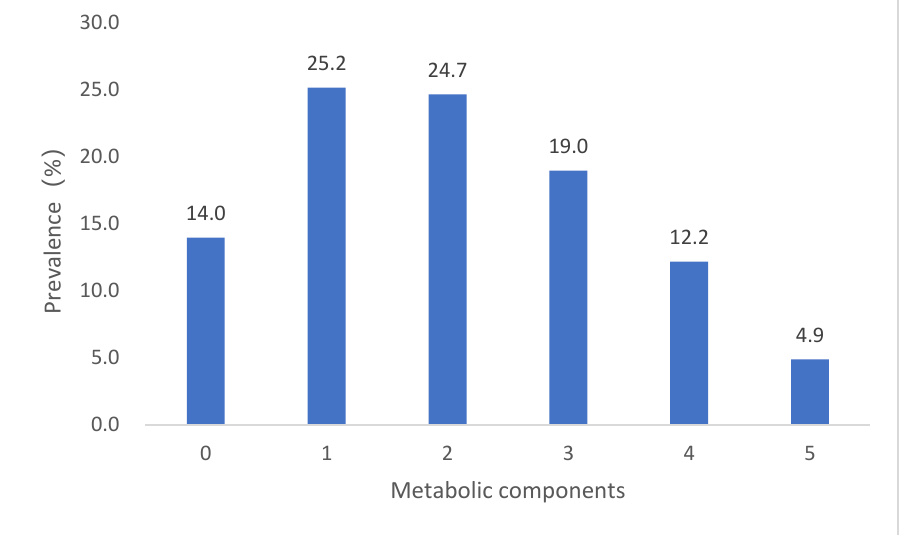
Figure 2. Metabolic components among adults in China.